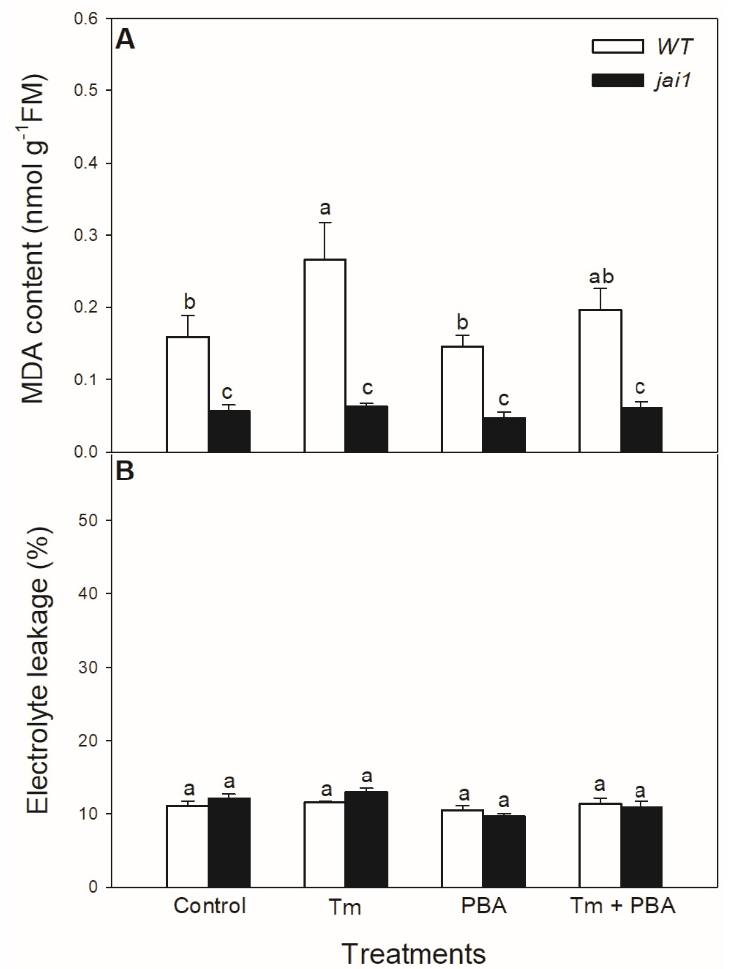
Figure 9. Changes in malondialdehyde (MDA) content ( A ) and electrolyte leakage ( B ) from the leaves of wild-type (WT) and JA signalling mutant (jai1) tomato plants exposed to 5 µ g mL − 1 tunicamycin (Tm), 1 mM 4-phenylbutyrate (PBA), and Tm + PBA for 6 h. Results are the means ± SE. Data with different letters indicate significant differences at p < 0.05 level, n = 3.